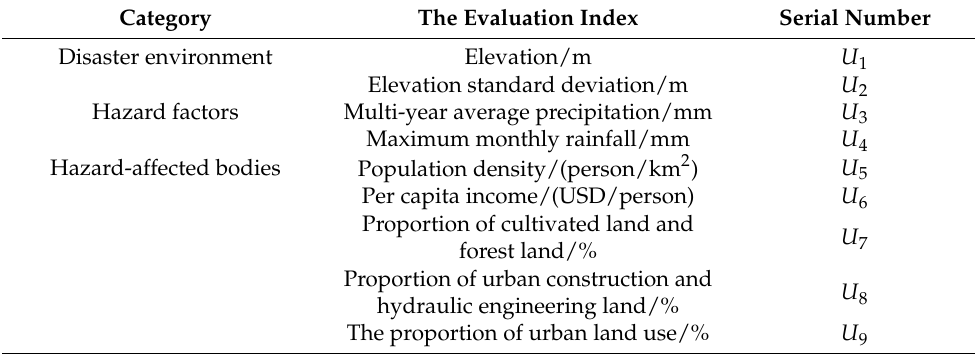
Table 2. Flood disaster assessment index system of the Anyang